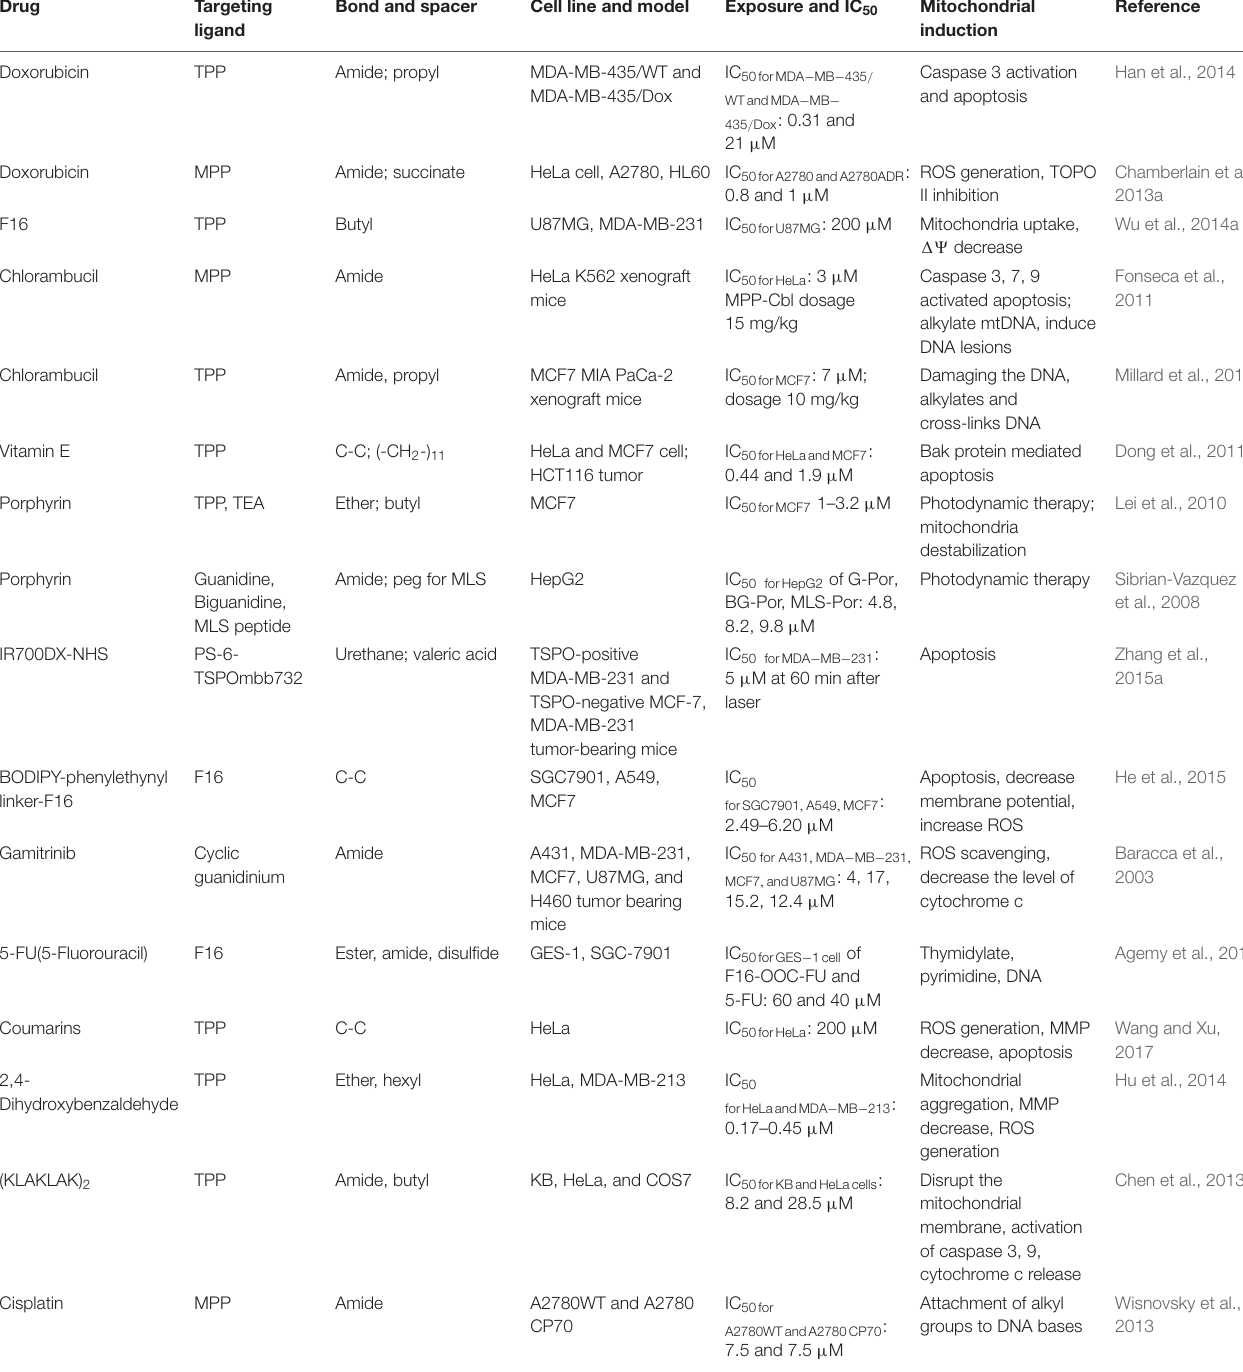
TABLE 1 | Some specific characteristics of mitochondria-targeting ligands and anticancer drug